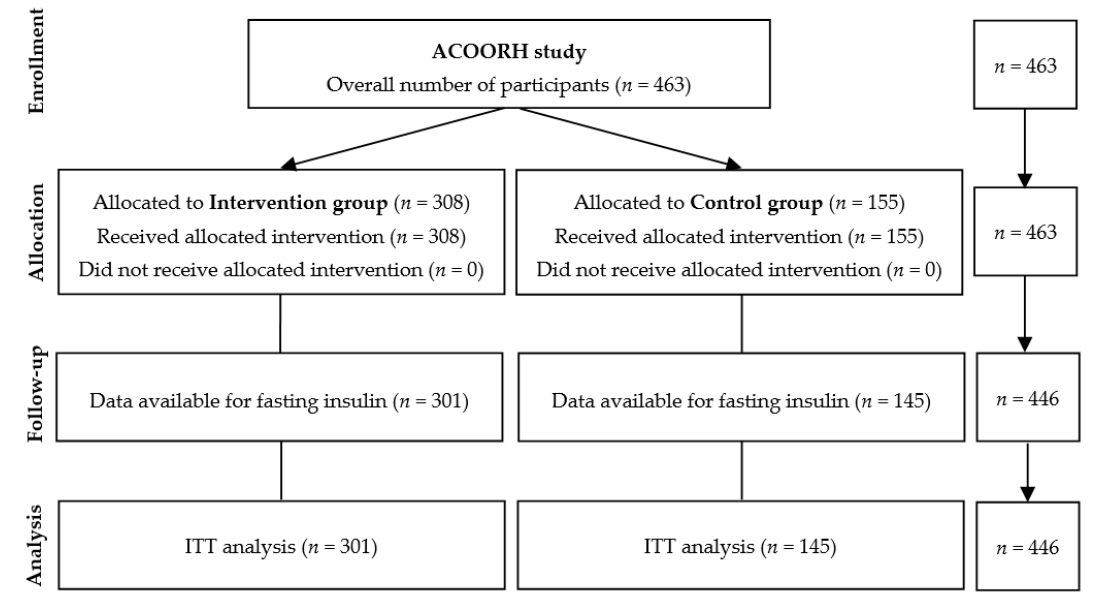
Figure 1. Flow chart.